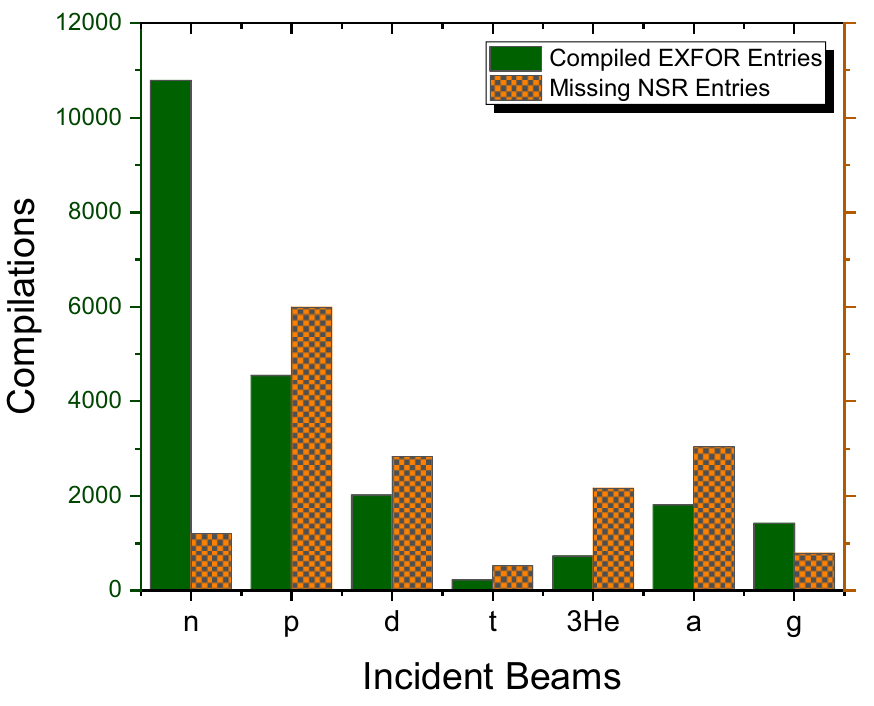
Figure 4. EXFOR completeness for neutron-, charged- and photonuclear-induced